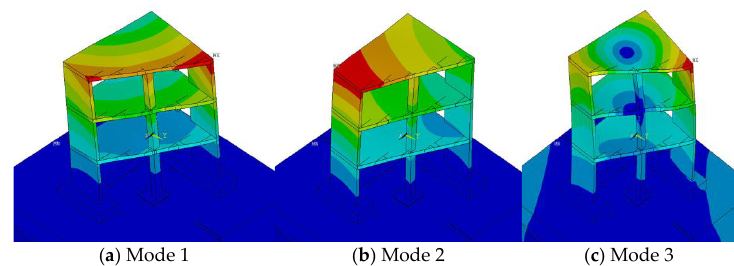
Figure 17. Mode shapes of the SMART 2013 RC structure for the model Case 3.